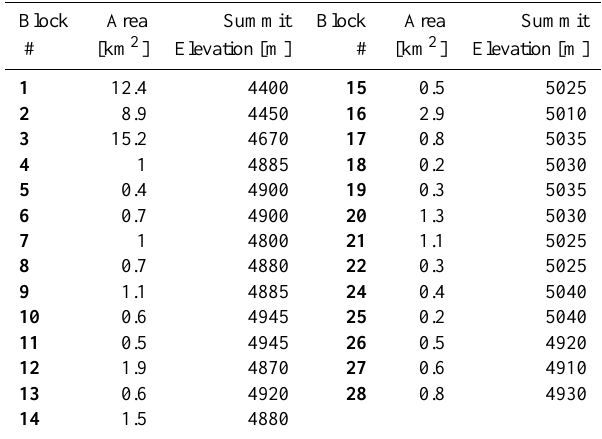
compressive sediment ridge, indicating frontal accretion